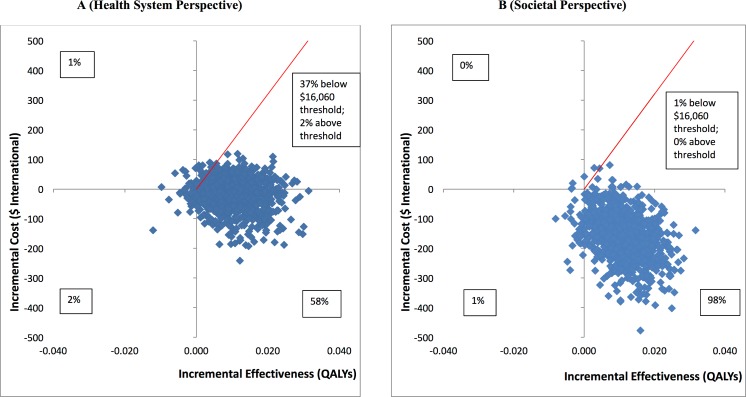
Cost-effectiveness planes: HAP plus EUC compared to EUC.(A) Health system perspective; (B) societal perspective. EUC, enhanced usual care; HAP, Healthy Activity Programme; QALY, quality-adjusted life year.